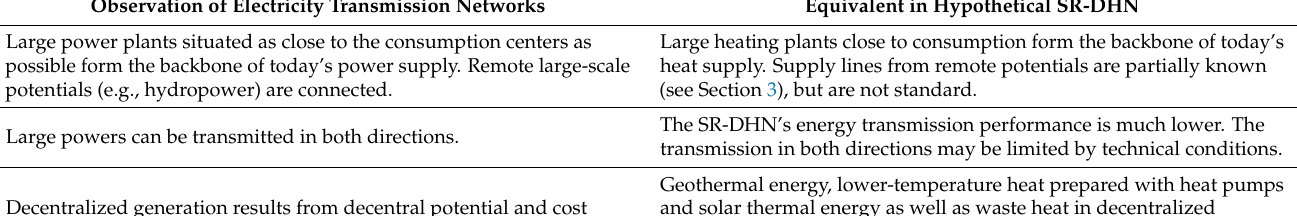
Table 2. Comparison with electricity transmission networks. Source: stakeholder and expert workshop. Observation of Electricity Transmission Networks Equivalent in Hypothetical